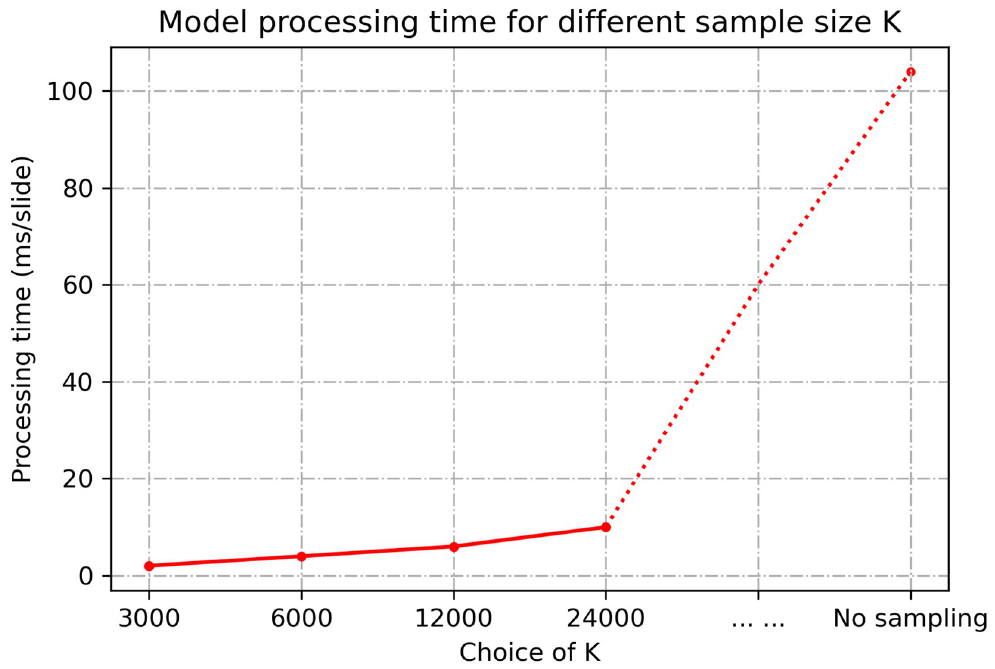
Fig 13. Model processing time for different sample size K. We evaluated the time of making prediction for one slide using the proposed BCR-Net under different sample size K. The red dot indicated the processing time for different choices of K. No sampling means that the intelligent sampling was not applied (i.e., all feature vectors were in the